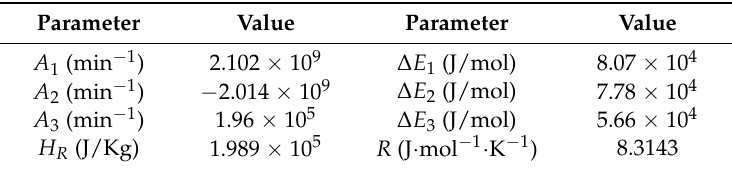
Table 1. Cure kinetic parameters of 3501-6 epoxy resin